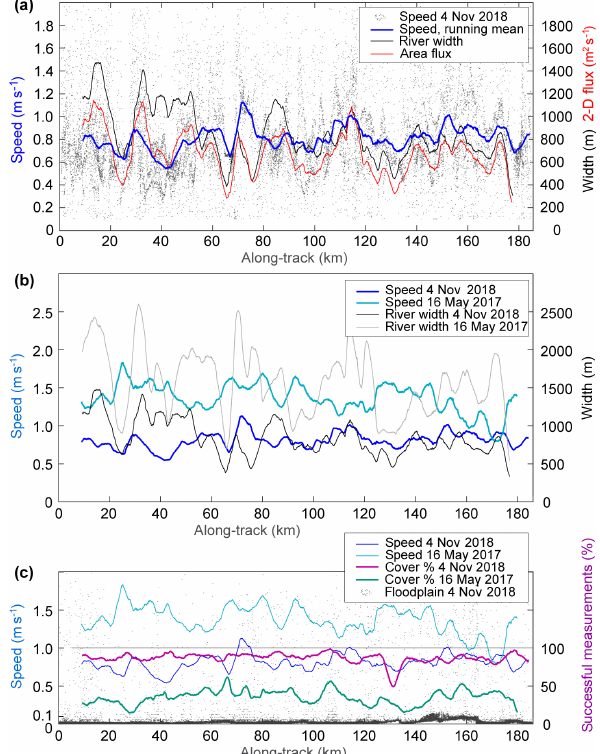
Figure 10. The longitudinal profile of speeds and river widths de- rived from near-simultaneous Planet cubesat images. (a) Measure- ments from 4 November 2018. Small dots represent the individ- ual speed measurements; the blue line represents the 4km running mean of individual measurements; the black line represents the river width from velocities (running mean); the red line is the surface area flux as a product of the cross-sectional average speed and river width (running mean). (b) The running means of surface speeds and the river width for 4 November 2018 (dark blue and black respec- tively) and 16 May 2017 (light blue and grey respectively). (c) Indi- cators of result quality. Small dots are speeds on stable ground for 4 November 2018, i.e. outside of the river. The green and turquoise lines are the percentage of successful measurements (i.e. measure- ments passing the correlation coefficient threshold) compared to the complete river mask. Blue and light blue lines in (c) are the speeds as in (b)